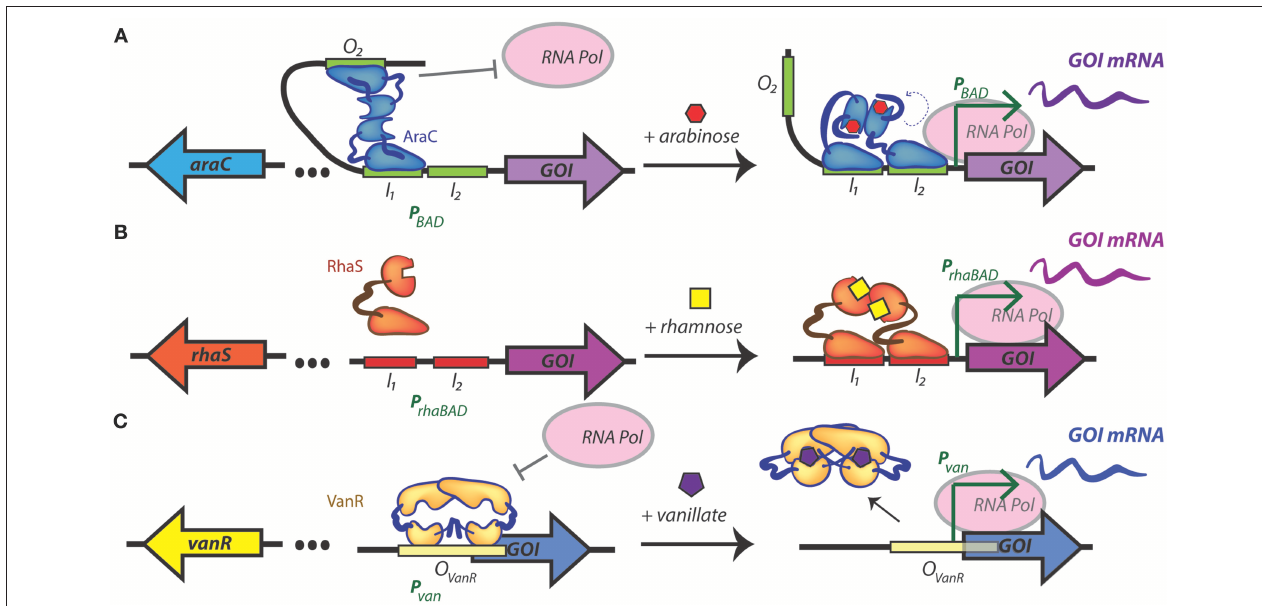
FIGURE 1 | Regulatory mechanisms of inducible promoters recently introduced into cyanobacteria. (A) Arabinose-inducible gene expression from P BAD , which is both positively and negatively regulated by the transcriptional regulator AraC. In the absence of arabinose, an AraC dimer contacts the O 2 and I 1 half sites of the promoter favoring the formation of a DNA loop that is unfavorable for RNA polymerase binding. When arabinose is present, AraC undergoes a structural change that releases the DNA loop, and ideally positions an AraC activation domain that promotes gene transcription. (B) Rhamnose-inducible gene expression from P rhaBAD . In the absence of rhamnose RhaS is unable to dimerize, limiting its capacity to bind to promoter elements. In the presence of rhamnose, a dimer of RhaS binds to the I 1 and I 2 repeat half-sites of the rhaBAD promoter, recruiting RNA polymerase and activating the transcription of the target gene. (C) The vanillate-inducible promoter, P van , is repressed by a dimer of VanR bound to its operator. When vanillate is present, two molecules bind the VanR dimer, resulting in a conformation change and release of transcriptional repression. I 1 , binding site 1 in P BAD and P rhaBAD ; I 2 , binding site 2 in P BAD and P rhaBAD ; GOI, gene of interest; mRNA, messenger RNA; O 2 , operator of P BAD ; O vanR , operator in P van ; RNA pol, RNA polymerase. In all cases, left and right panel represent uninduced and induced promoters,